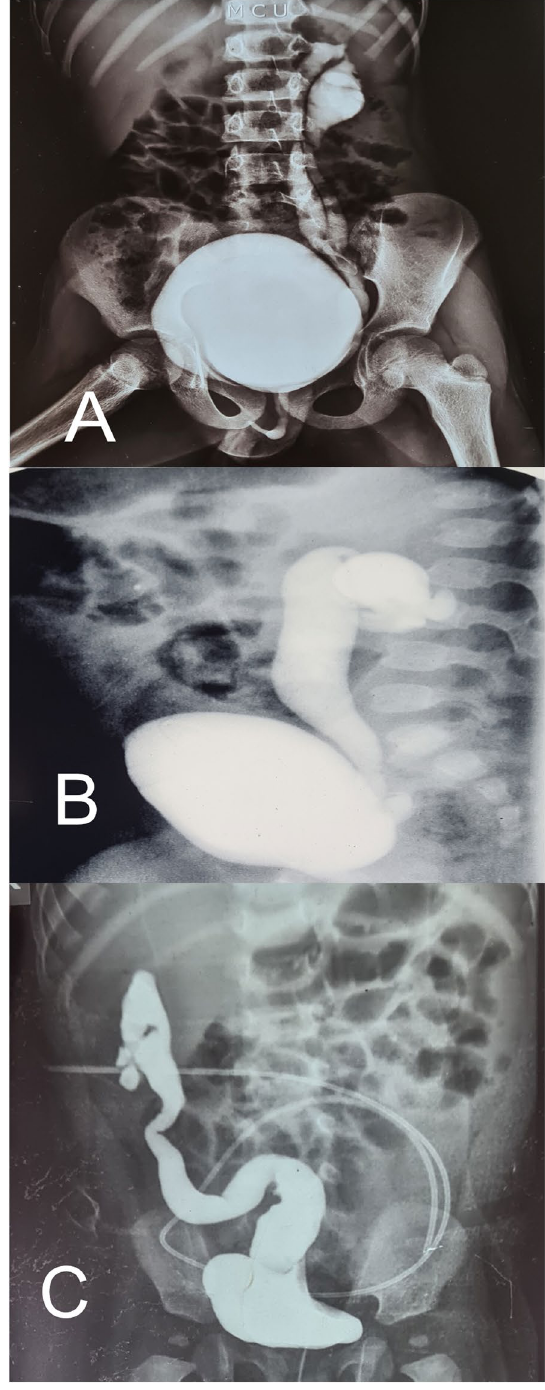
Fig. 2 A MCU showing reflux into left kidney with “Y” duplication. B MCU showing reflux into the lower moiety with “Drooping lily”sign. C Reflux into the upper moiety ureter with cystic dilatation of lower